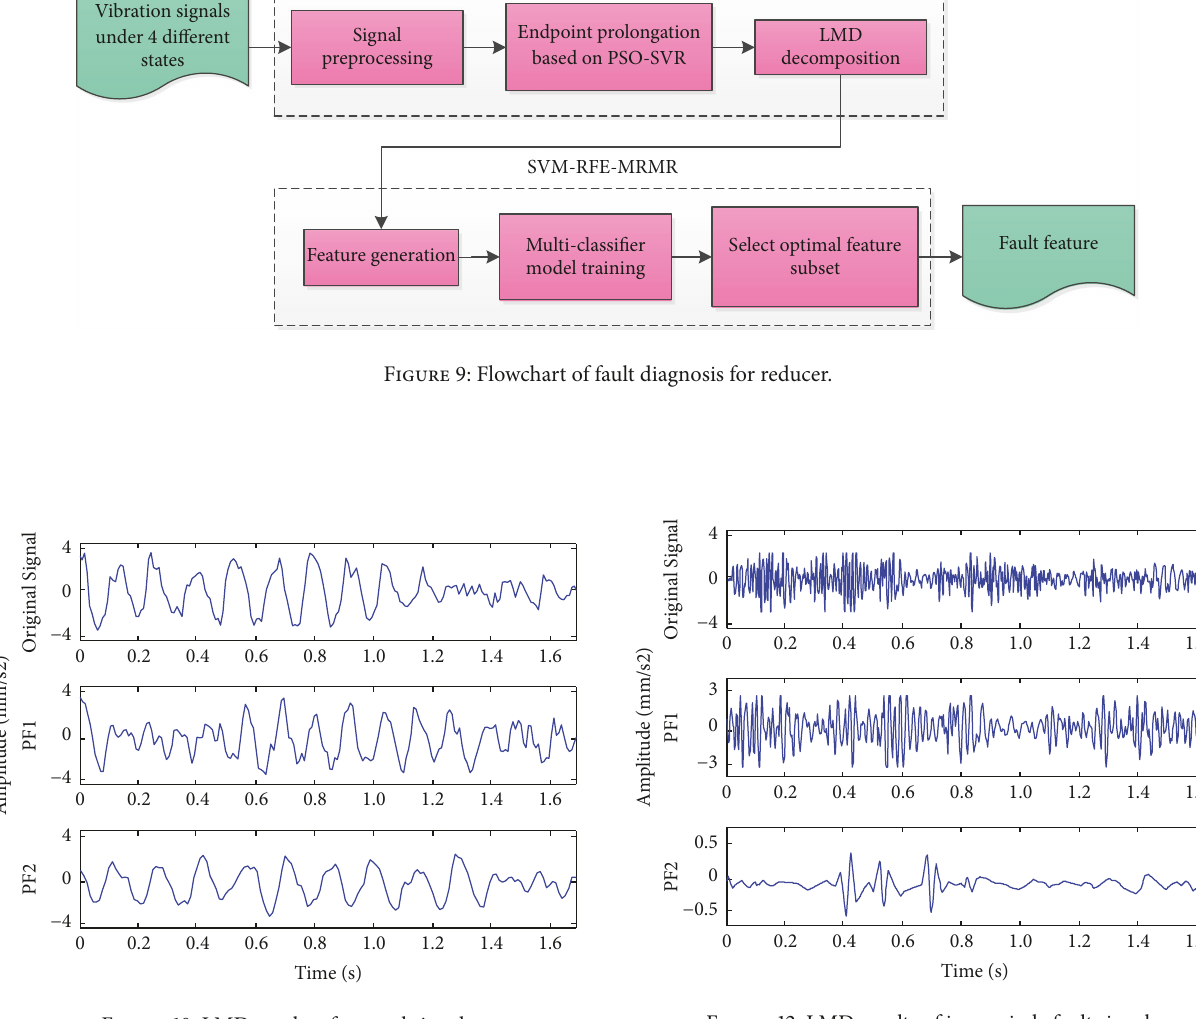
Figure 10: LMD results of normal signal.